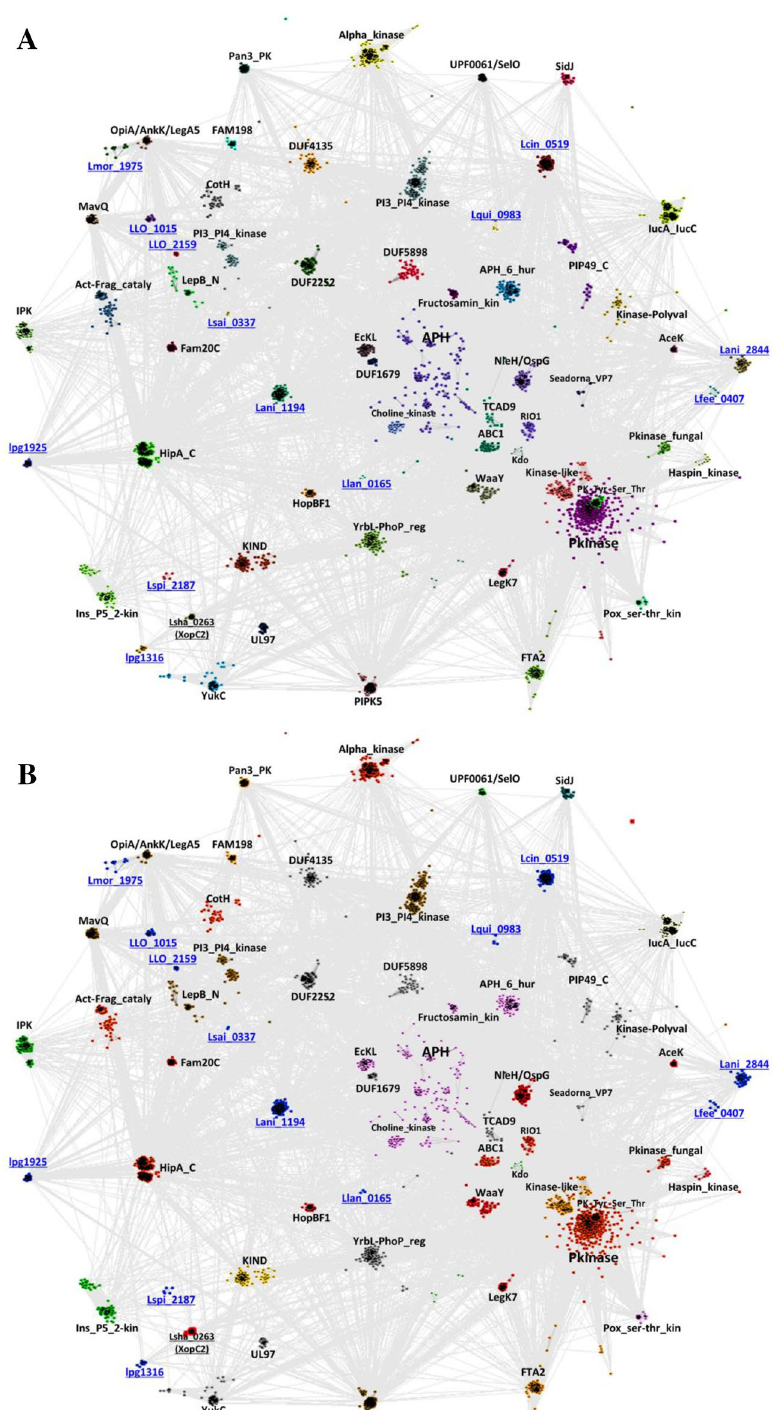
Figure 4. Sequence similarity graph for novel Legionella kinases and known PKL families from all domains of life. The CLANS graph includes representatives of all known PKL families (see “Methods” section). Graph edges represent protein sequence similarities detected by all-to-all BLAST comparisons up to the E-value of 1 47 . Pfam identifiers of selected families shown, for novel families, symbols of representative genes used. Novel families of Legionella (pseudo)kinases marked in blue underline. ( A ) Coloring by families. ( B ) Coloring by dominant function: red — protein phosphorylation, cyan — phospholipid phosphorylation, lime — lipopolysaccharide phosphorylation, pink — fructosamine phosphorylation, dark green — phosphorylation of inositol and derivatives, magenta — small molecule phosphorylation, brown — phosphorylation of phosphatidylinositol and derivatives, orange — pseudokinase (likely non-enzymatic functions), pale yellow — biosynthesis of small molecules, green-grey — glutamylation, light green — AMPylation (adenylylation), grey — unknown function or function predicted but unverified, blue — novel Legionella